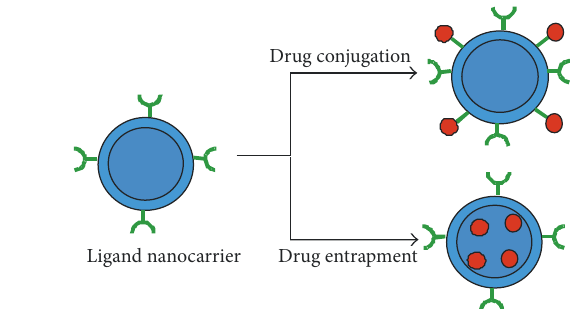
Figure 4: The drug conjugation to surface of a carrier and an entrapment process (the figure is based on